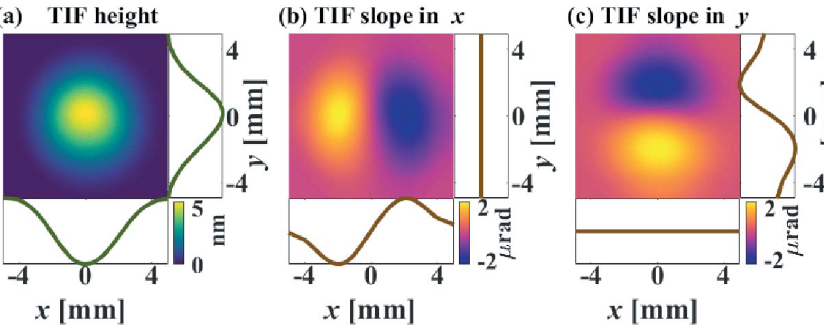
Figure 12 Height ( a ), slope in x ( b ) and slope in y ( c ) of the IBF TIF generated with a 5 mm